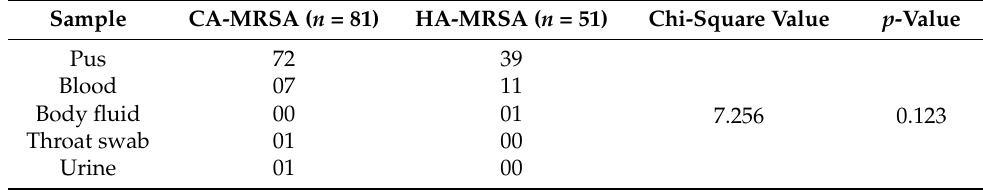
Table 1. Isolation of MRSA from various clinical